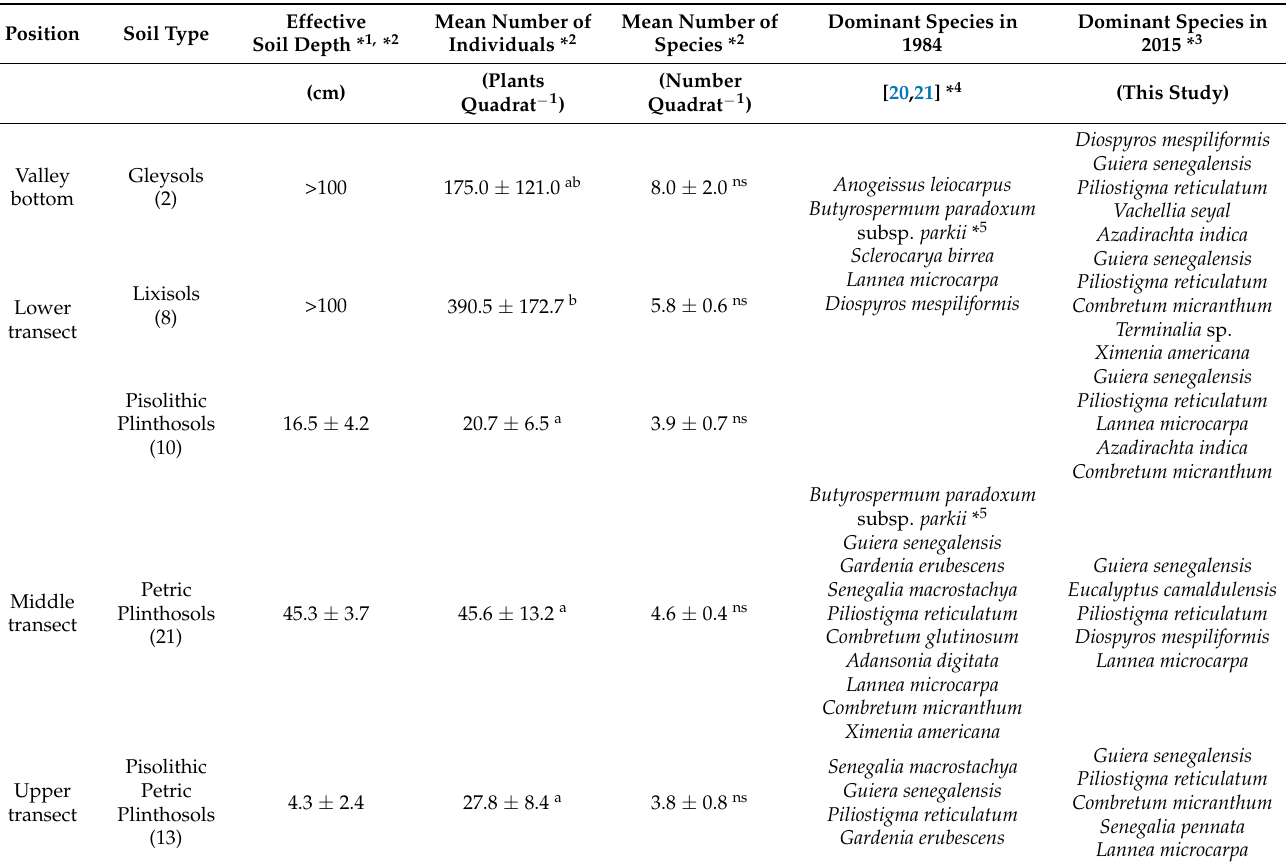
Table 3. Relationships between topographic position, soil type, woody vegetation, and changes in dominant species in the last 31